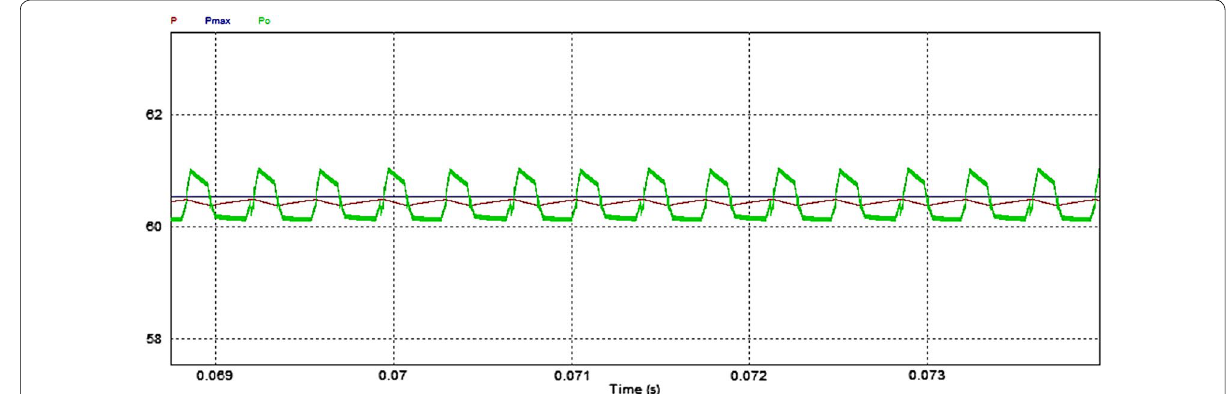
Fig. 11 Zoom in the output powers for Kalman filter based MPPT under STC